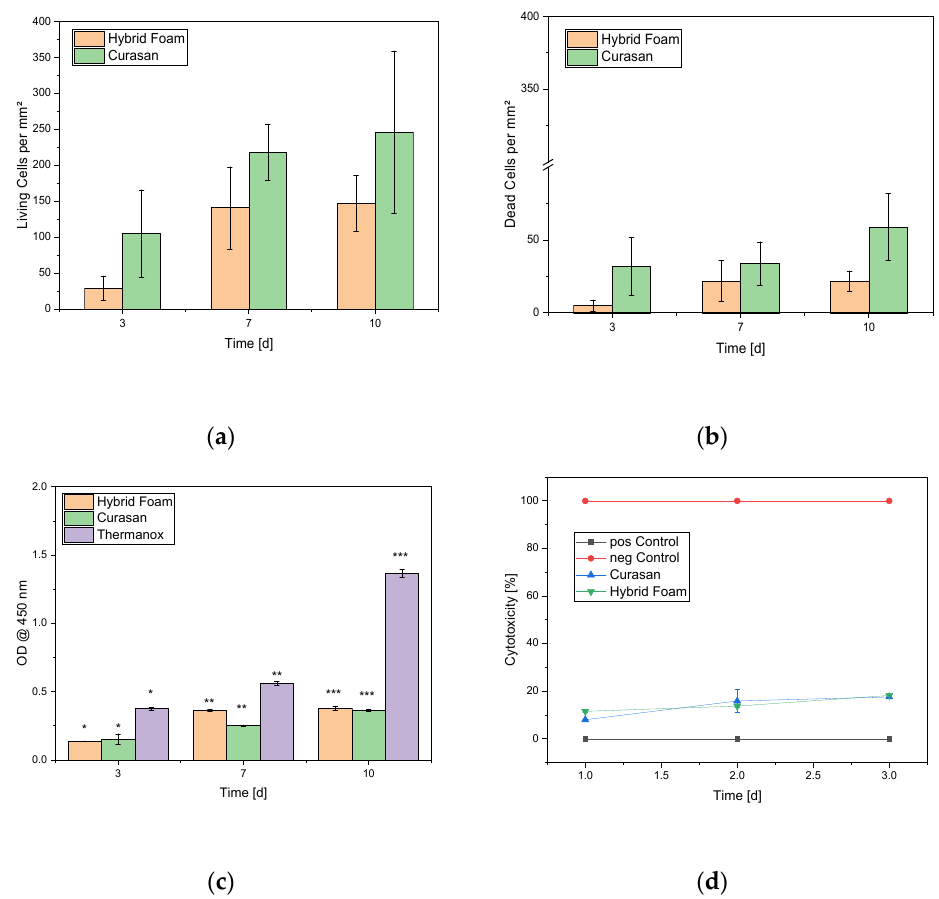
Figure 14. Overview of the biocompatibility tests: cell counts of ( a ) living cell numbers and ( b ) dead cell numbers per mm 2 on the materials after 3, 7 and 10 days; ( c ) WST assay to demonstrate proliferation of MG 63 on the samples. Means and controls were statistically compared to assess the material effect. Significances set at p < 0.05 are assigned the same symbol. ( d ) Cytotoxicity of hybrid foams compared to the Curasan control; pos. Control = cells, neg. Control =